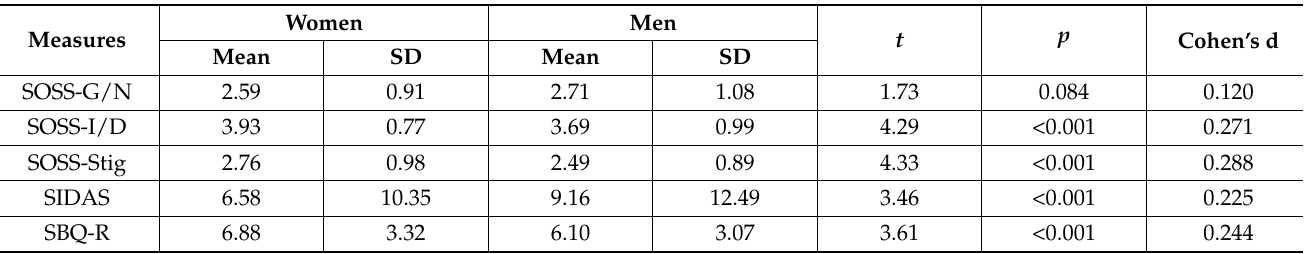
Table 5. Means and Standard Deviations of each measure in men and women and the results of the t -tests for determining gender